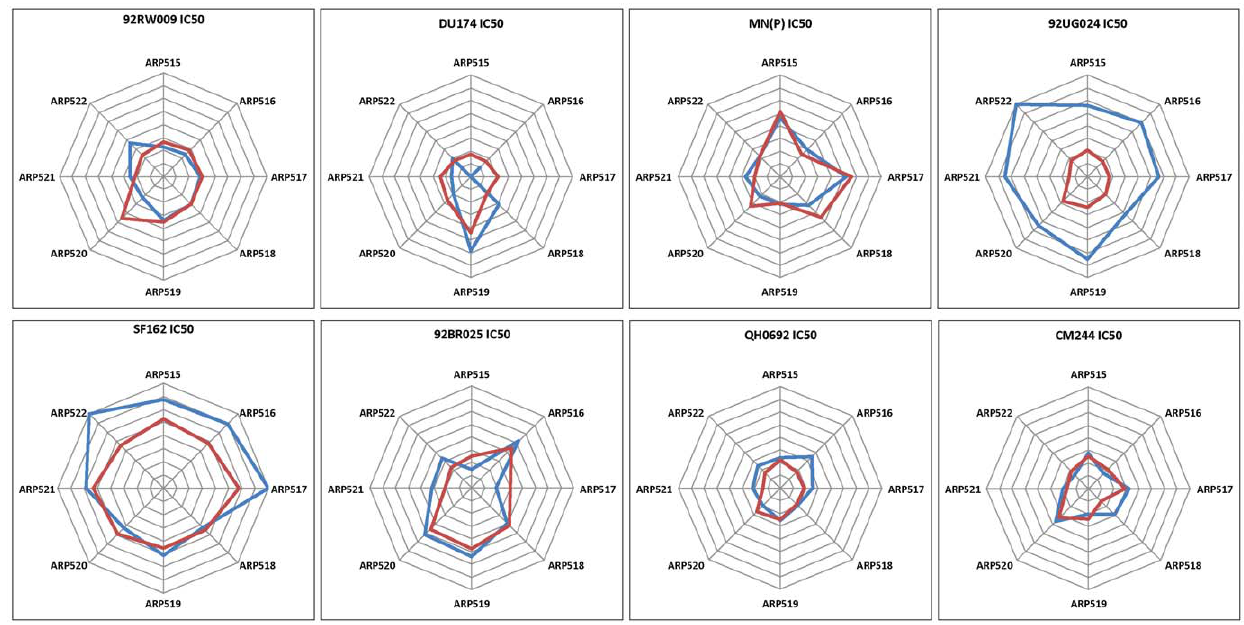
Figure 4. Comparison of PSV and VI assays across plasma by circular ‘‘radar’’ plots. The scales were adjusted such that no neutralization (IC50 , 20) is at the centre, and the outer ring is strong neutralization (IC50 . 1280). The concentric grid-lines are 2-fold dilution steps. Lines from the centre represent an axis for each plasma. The geometric mean IC value for PSV (blue lines) and PBMC (red lines) against each plasma is plotted, and the points joined.